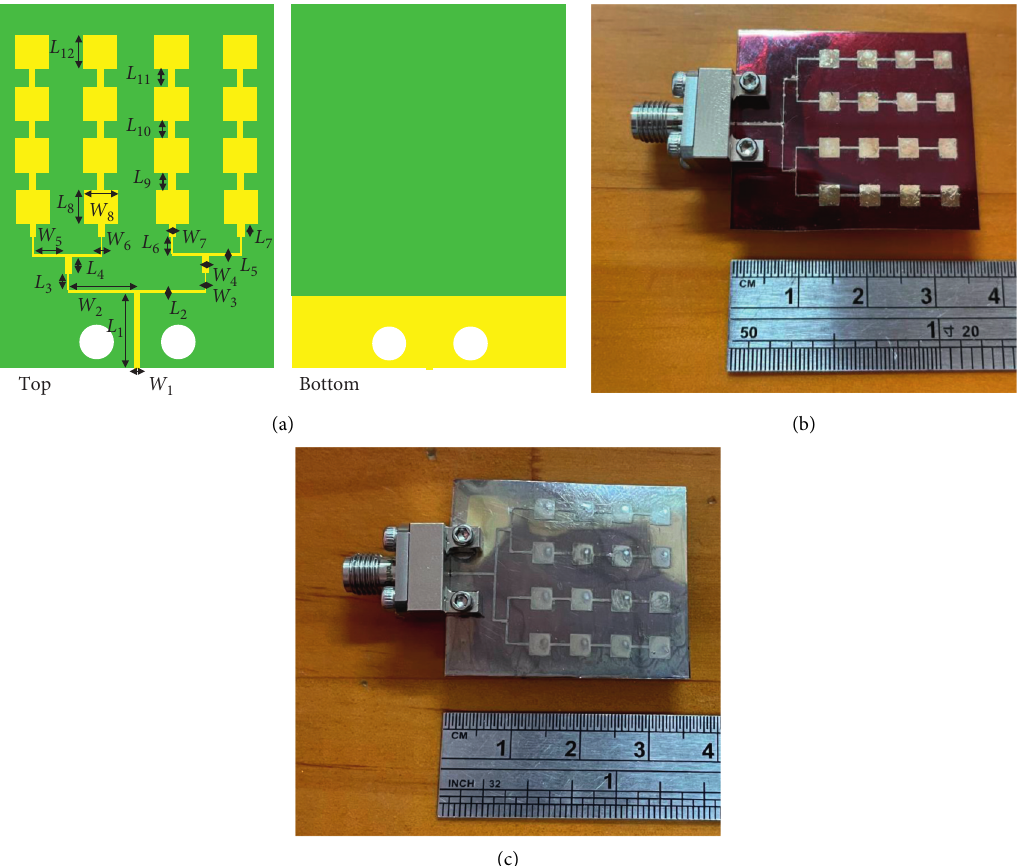
Figure 15: (a) The geometry of the fully inkjet-printed 4 × 4 flexible patch array and the photographs of the antenna fabricated on (b) PI and (c) PEN.